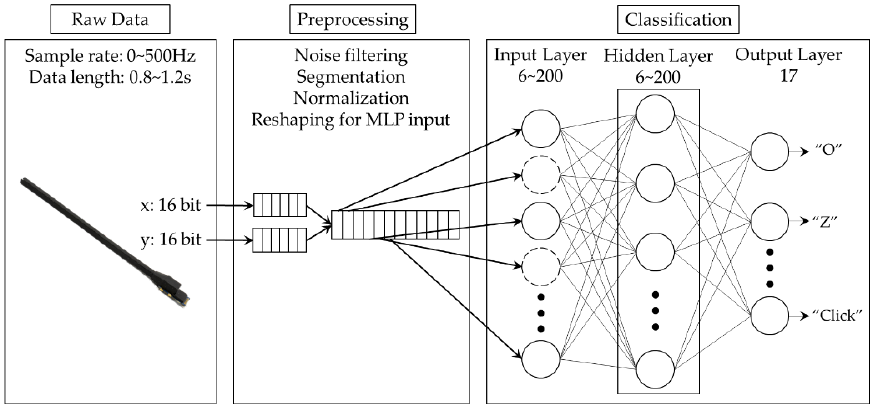
Figure 3. The framework for the proposed finger gesture recognition system.